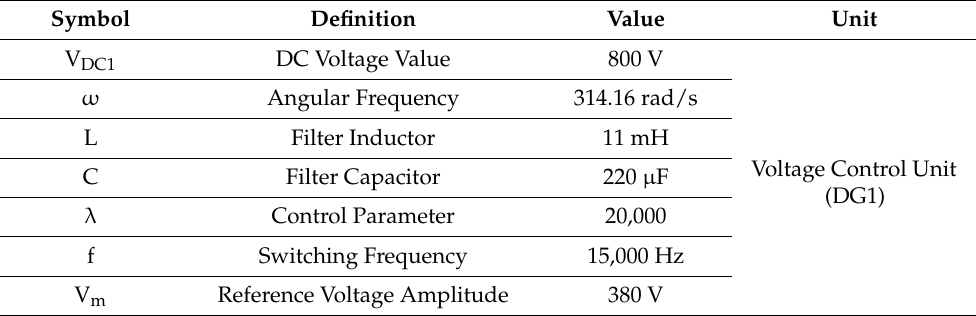
Table 6. Values of Distributed Generation Sources and PI Control